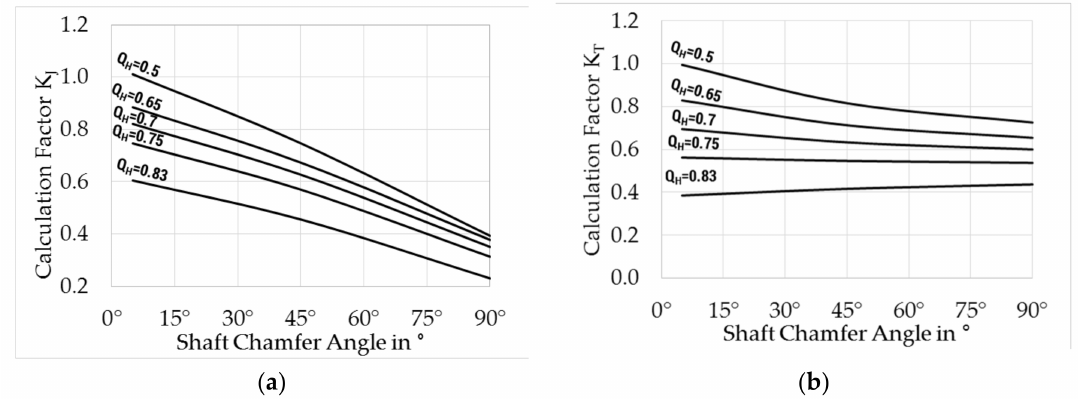
Figure 5. Factors influencing joining force ( a ) and maximal torque ( b